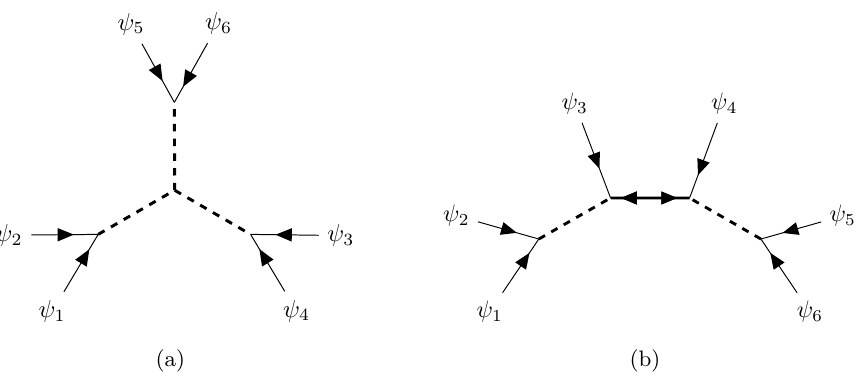
Figure 2. The two tree-level topologies relevant to six-fermion operators. For some operators, some fermion arrows may be reversed. The exotic propagators are shown in bold. (a) The scalar-only topology. (b) The scalar-plus-fermion or central-fermion